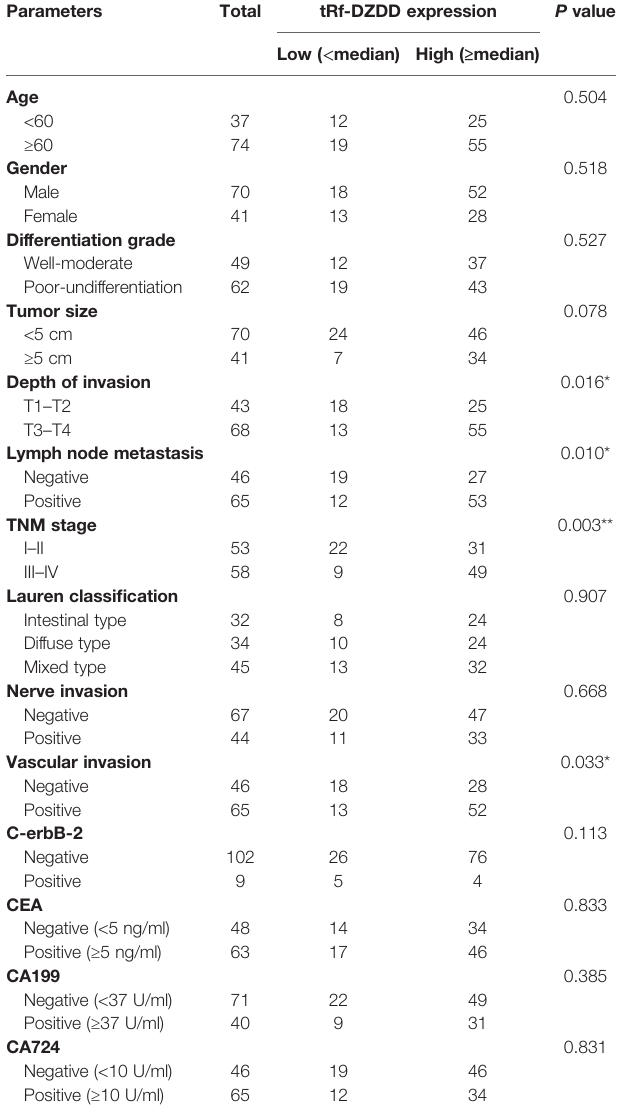
TABLE 2 | The association between tRF-31-U5YKFN8DYDZDD expression and clinicopathologic parameters in 111 GC specimens. Parameters Total tRf-DZDD